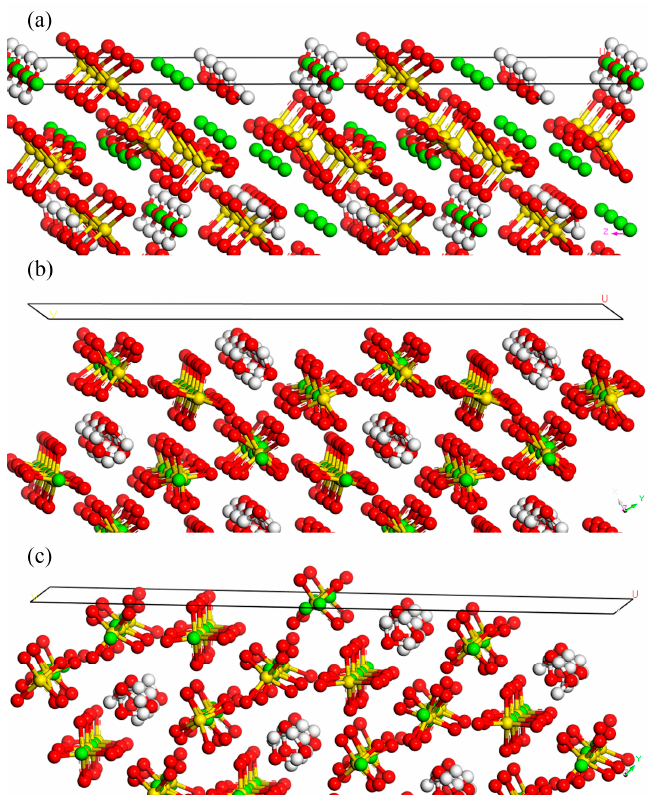
Figure 5. Structures of the crystal faces of ( a ) (400), ( b ) (310), and ( c ) (530). (Note: Red balls represent O. White balls represent H. Yellow balls represent S. Green balls represent Ca).